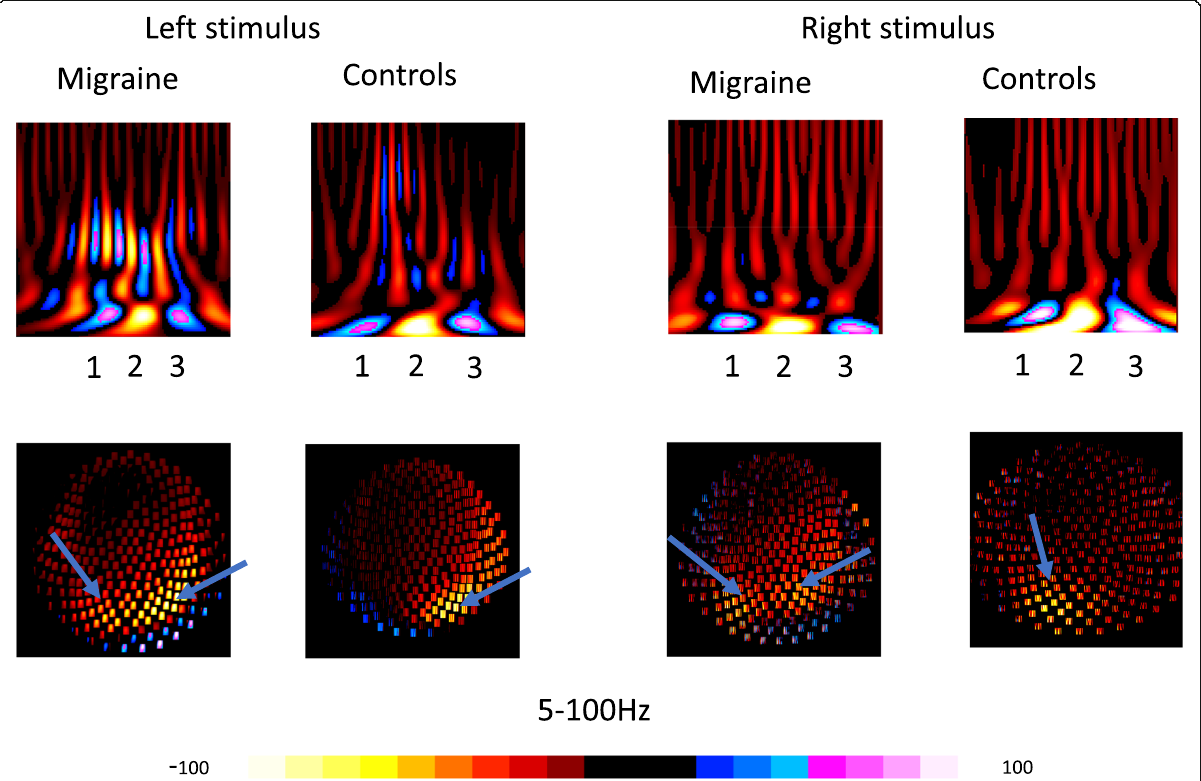
Fig. 2 Time-frequency analysis of visual-evoked magnetic fields (VEFs): An example of the results from time-frequency analysis recorded from a migraine subject and a healthy control. Polarity spectrograms and contour maps (second and fourth) of neuromagnetic signals showed a focal activation (lighting color bar) in 5 – 30 Hz in the low frequency band (50-100Hz) and 100-300Hz in the high frequency range during a visual stimulus. There is increased spectral power in the two frequency bands of 100 – 300 and 500 – 700 Hz in the polarity spectrograms. The contour maps showed a similar activation pattern of visual evoked magnetic fields (VEF) in migraines and